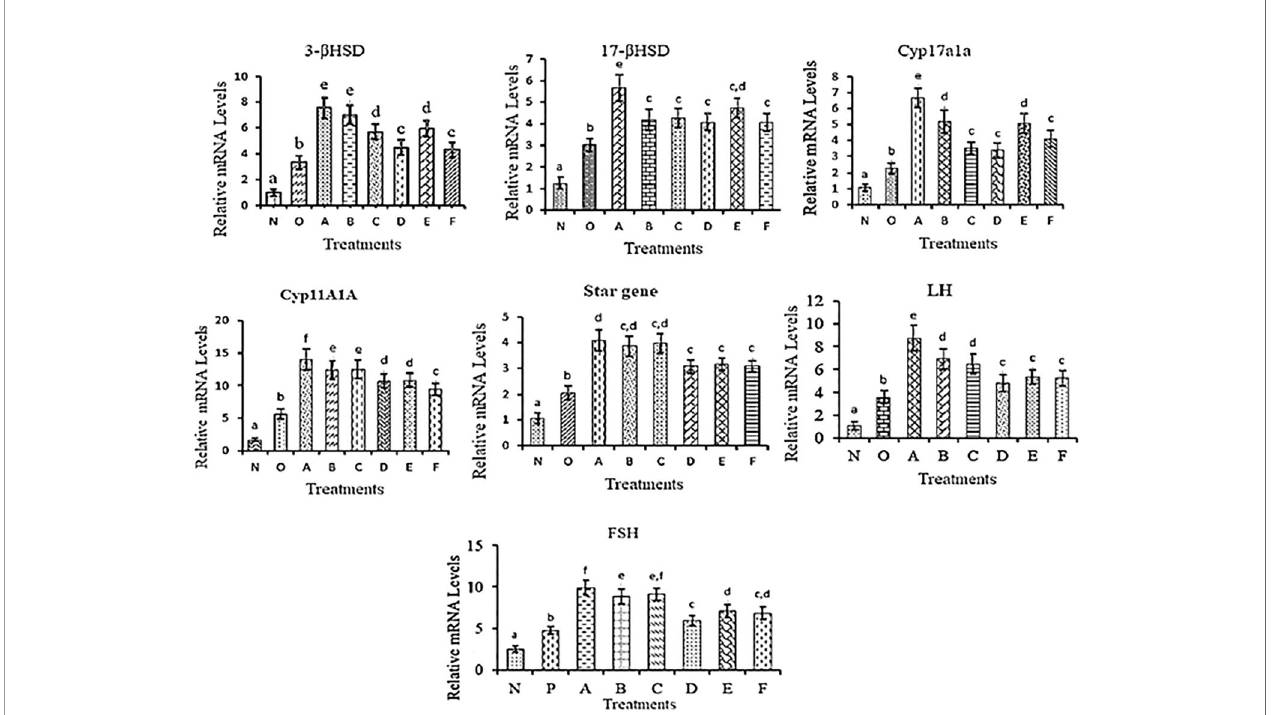
FIGURE 8 | mRNA expression levels of different reproductive genes in testes collected at different time points in different treatment groups. The different letters used indicates signi fi cant differences and superscripts indicate non-signi fi cant differences in mRNA expression level. Data were expressed as mean ±